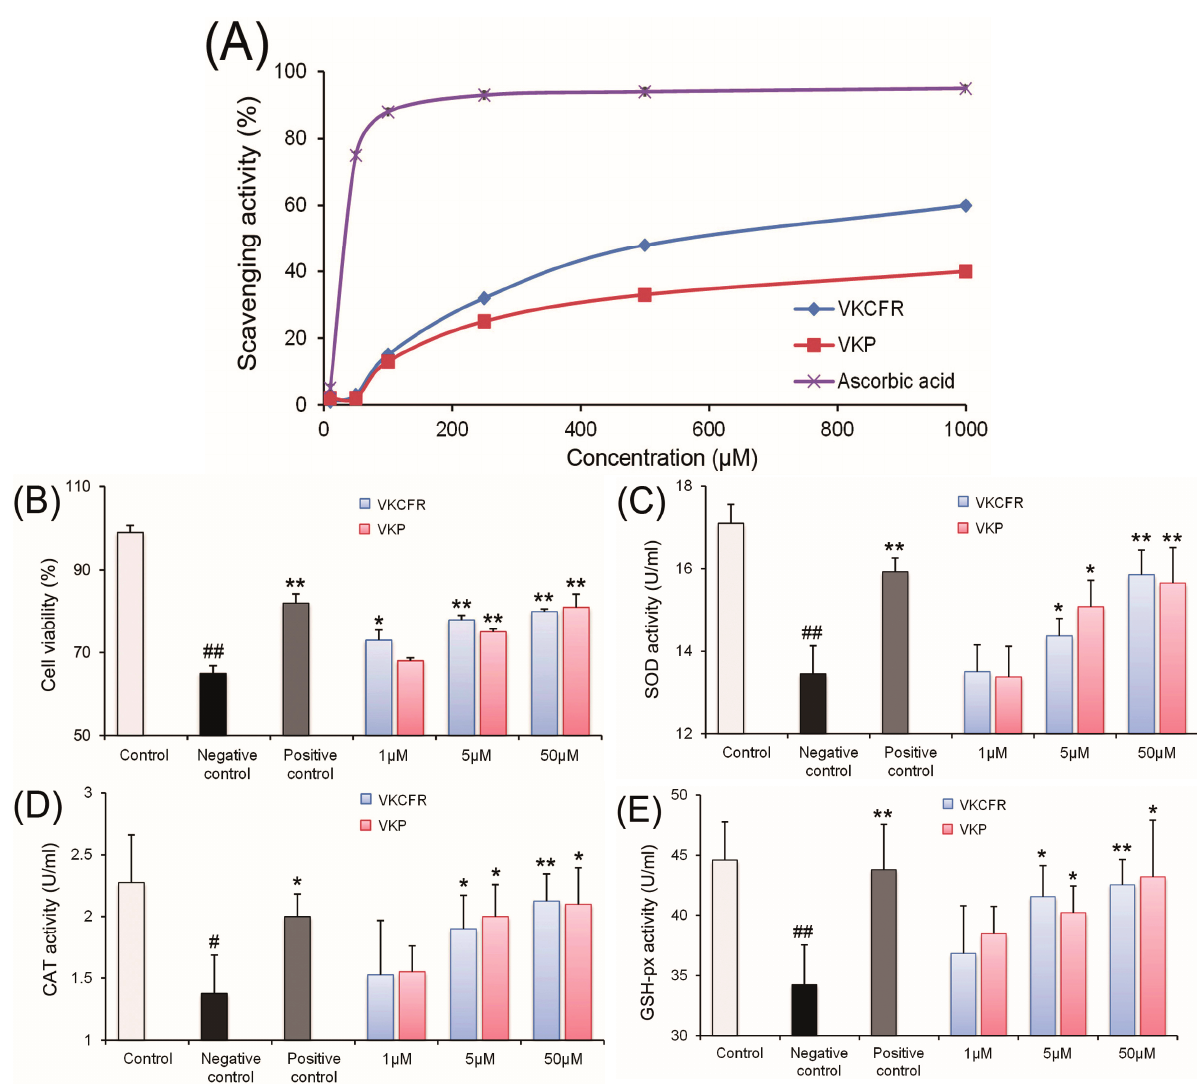
Figure 3. ( A ) Hydroxyl radical scavenging activity of VKP and VKCFR. ( B ) Protective effects of VKP and VKCFR pretreatment at different concentrations (1, 5, and 50 μ M) on RCMEC exposed to 300 μ M H O in the MTT assay. ( C ) Effects of VKP and VKCFR 2 2 treatment at different concentrations (1, 5, and 50 μ M) on SOD enzymatic activity in RCMEC exposed to H O . ( D ) Effects of VKP and VKCFR treatment at different 2 2 O exposure on RCMEC CAT enzymatic activity. concentrations (1, 5 and 50 μ M) with H 2 2 ( E ) Effects of H O exposure with VKP and VKCFR treatment at different concentrations 2 2 (1, 5, and 50 μ M) on RCMEC GSH-px enzymatic activity. Significant difference compared to the control at # p < 0.05, ## p < 0.01; significant differences compared to the